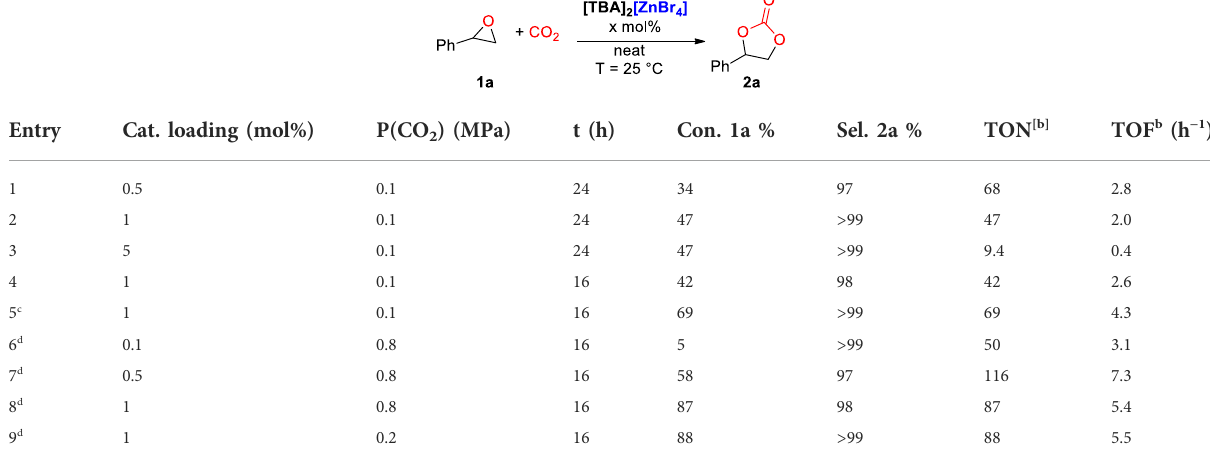
a ReactionperformedinsealedvialswithaCO 2 balloon.Reactionconditions:styreneoxide(SO)2.19 mmol;T=25 ° C;Conversionandselectivitydeterminedby 1 HNMR,usingmesitylene as the internal